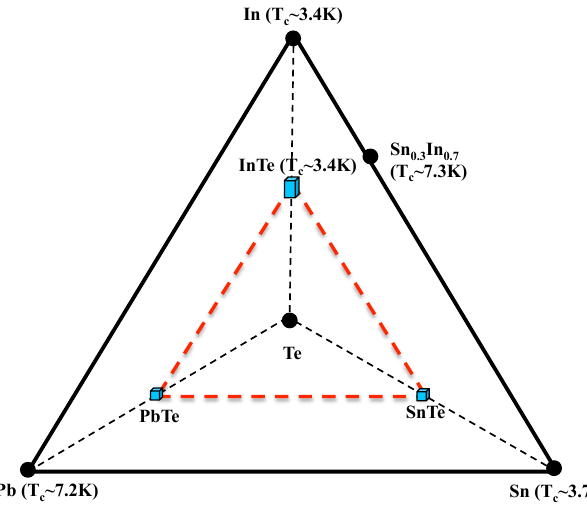
Figure 7. Phase diagram of composition and superconductivity of the Pb-Sn-In-Te alloy system. The known superconducting metals or compounds Pb, Sn, In, InTe, and Sn 0.3 In 0.7 are marked on the diagram, respectively. Based on this superconducting phase diagram, we did thorough studies in the region marked with red dashed lines.